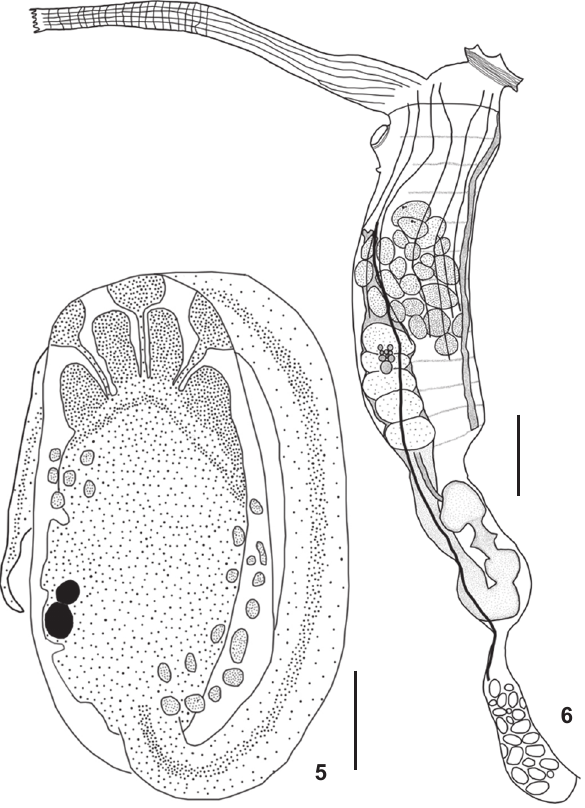
Figures 4-5. Sidneioides peregrinus sp. nov. : (4) zooid; (5) larva. Scale bars: 4 = 1 mm, 5 = 0.1